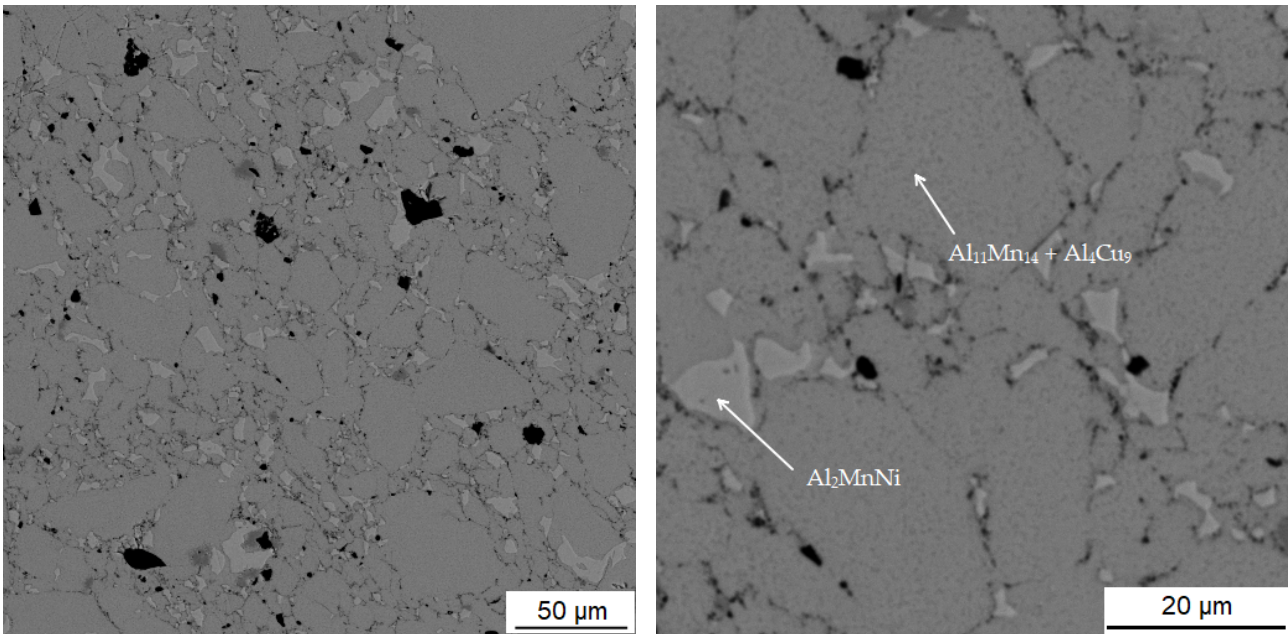
Figure 12. Microstructure of alloy with 100% excess of aluminum over stoichiometry sintered at 900 °C and heat-treated by annealing at 800 °C for 3